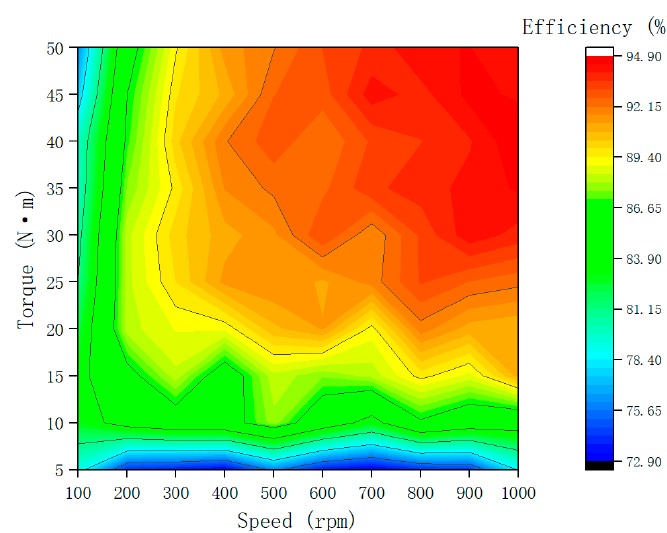
Figure 5. Motor efficiency MAP.